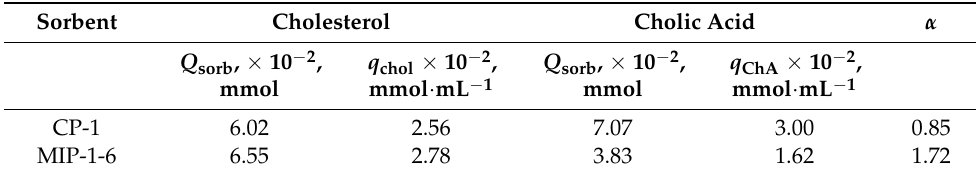
Table 9. Dynamic sorption characteristics of cholesterol and cholic acid on CP-1 and MIP-1-6; v = 0.25 mL · min − 1 , H = 3.0